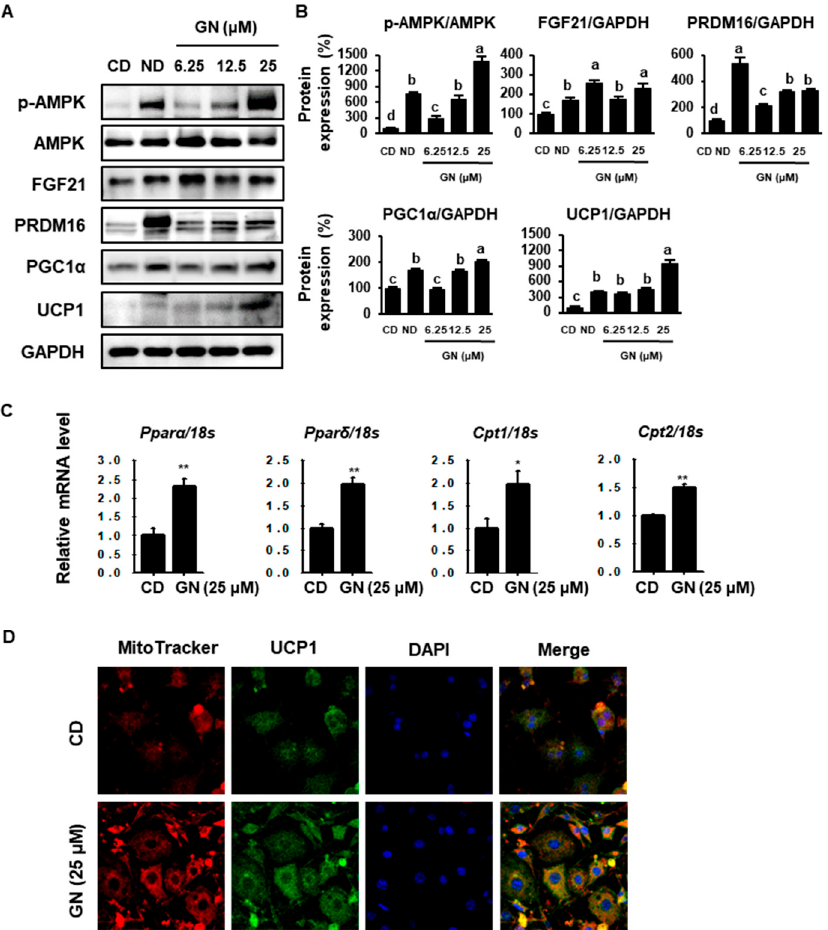
Figure 3. Effects of GN on expression of thermogenic markers and fatty acid oxidation-related genes. ( A , B ) Western blotting for the lipogenesis factors phosphorylated AMP-activated protein kinase (p-AMPK), AMPK, fibroblast growth factor (FGF21), PR domain containing 16 (PRDM16), peroxisome proliferator-activated receptor gamma co-activator 1 alpha (PGC1 α ) and uncoupling protein 1(UCP1) in 3T3-L1 cells and quantification of band density. ( C ) Relative mRNA expression levels of the adipogenic genes Ppar α , Ppar δ , Cpt1 and Cpt2 were determined by qPCR and normalized to 18S rRNA expression. ( D ) Immunofluorescence image of 3T3-L1 (400× magnification). Protein data are expressed as mean ± SD ( n = 4). Values with different letters are significantly different, p < 0.05 (a > b > c > d). mRNA data are expressed as mean ± SD ( n = 4). * p < 0.05, ** p < 0.01.